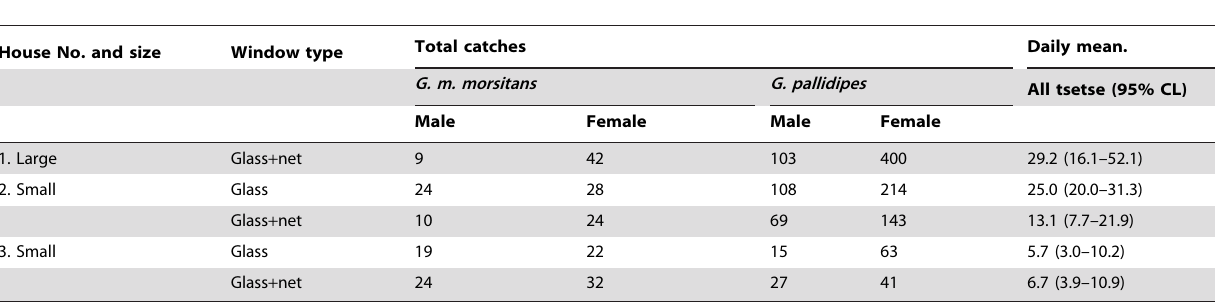
Table 3. Catches from houses used with various types of